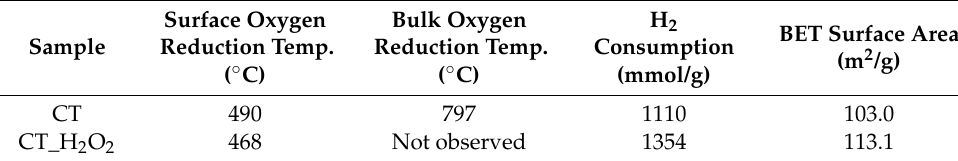
Table 1. H 2 -TPR results and BET surface area of CT and CT_H 2 O 2 .